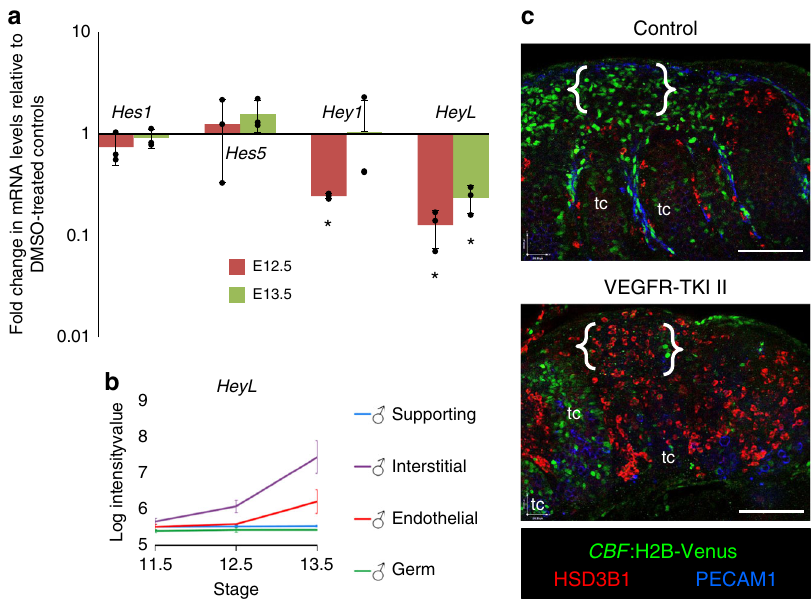
Fig. 7 Vasculature is required for interstitial Notch signaling. a qPCR analysis showing expression of Notch target genes ( Hes1 , Hes5 , Hey1 , and HeyL ) from E12.5 and E13.5 fetal testes cultured with VEGFR-TKI II (1.8 µ g/ µ l) for 48 h relative to their respective vehicle (DMSO)-treated controls. Data are presented as the mean ± SD of 3 independent biological replicates ( n = 3 litters, ≥ 5 gonads/litter). * P < 0.05 (two-tailed Student t -test). b Gene expression plot of HeyL expression generated from gonad lineage-speci fi c microarray data 42 , where cell lineages (supporting Sertoli cells, interstitial cells, endothelial cells, and germ cells) were independently plotted in different colors. Plot contains data for XY samples at stages E11.5, E12.5, and E13.5 for each cell type. In general, expression values below 6 are considered background levels of expression. For more information about this data set, see Jameson et al. 42 . c Immuno fl uorescence images of E12.5 CBF :H2B-Venus XY gonads cultured in DMSO (Control, top) or 1.8 µ g/ µ l VEGFR-TKI II (bottom) for 48 h. Disruption of vasculature resulted in loss of active Notch signal from the interstitium (Venus-positive cells; see brackets) and resulted in an increased number of differentiated Leydig cells (HSD3B1-positive); “ tc ” denotes testis